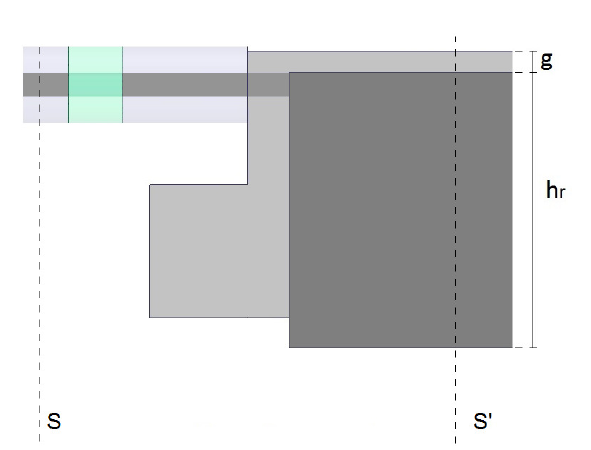
Figure 9. Section of the device involved in the second gap test: it is evaluated the performance by considering the device step from S section (upstream the air gap) to S’ (in the WG r step) and by varying the g parameter, which is related to the position of the pin insertion and to first ridge height.